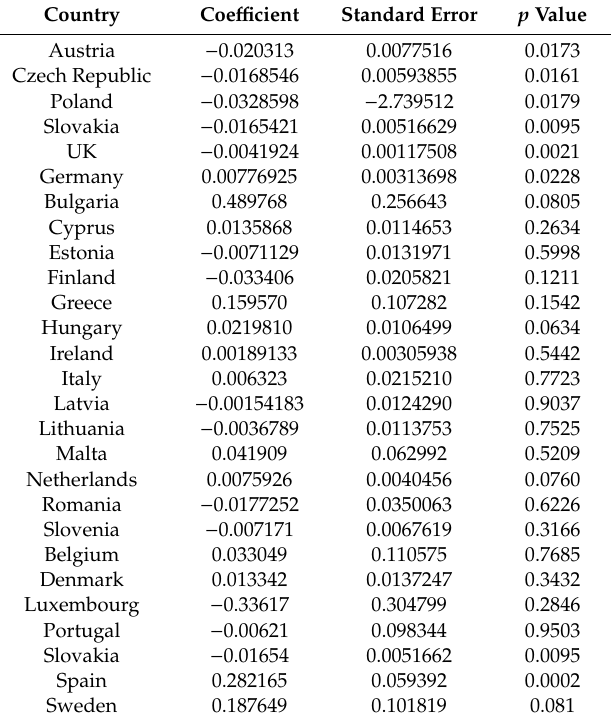
Figure 4. Mean CPI score and ad valorem to specific excise duty ratio across all EU Member States (data from 1995–2017). Table 1. Time series regression estimates of coefficients for change in ad valorem to specific duty ratio per unit change in CPI score (data for Croatia insufficient for analysis).